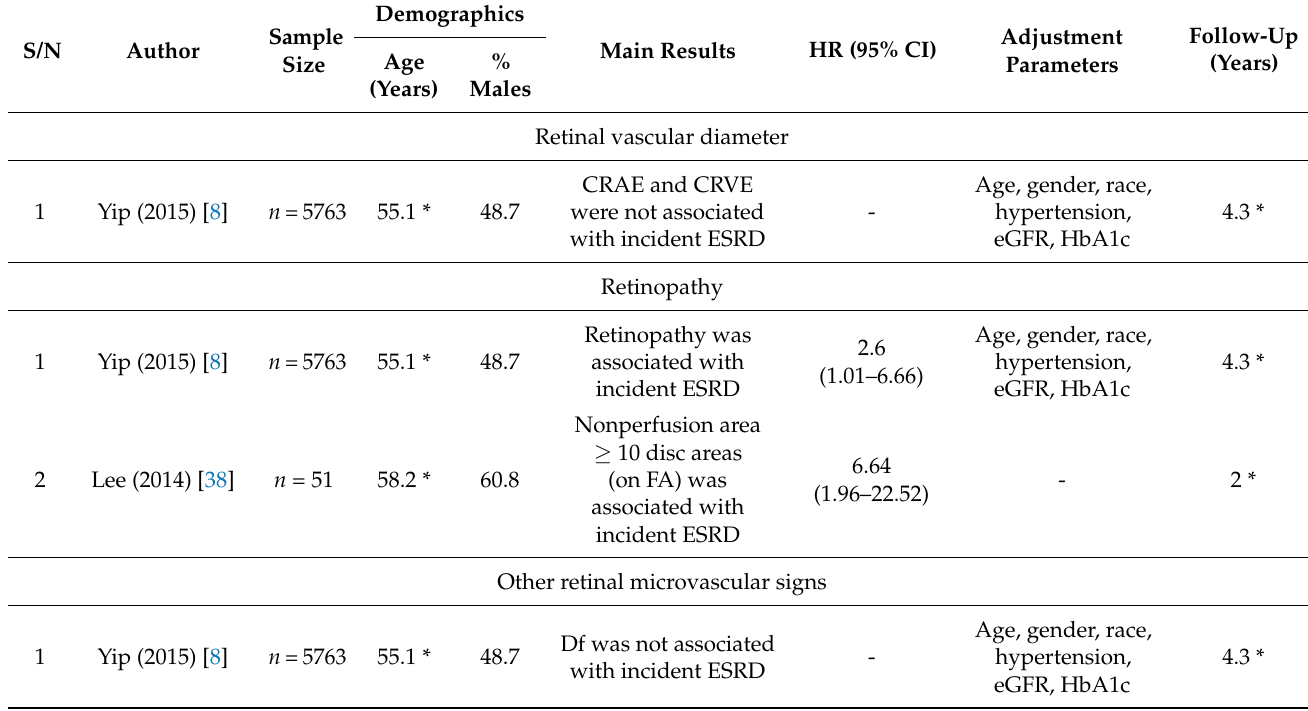
Table 7. Retinal microvascular signs and incident ESRD in diabetic